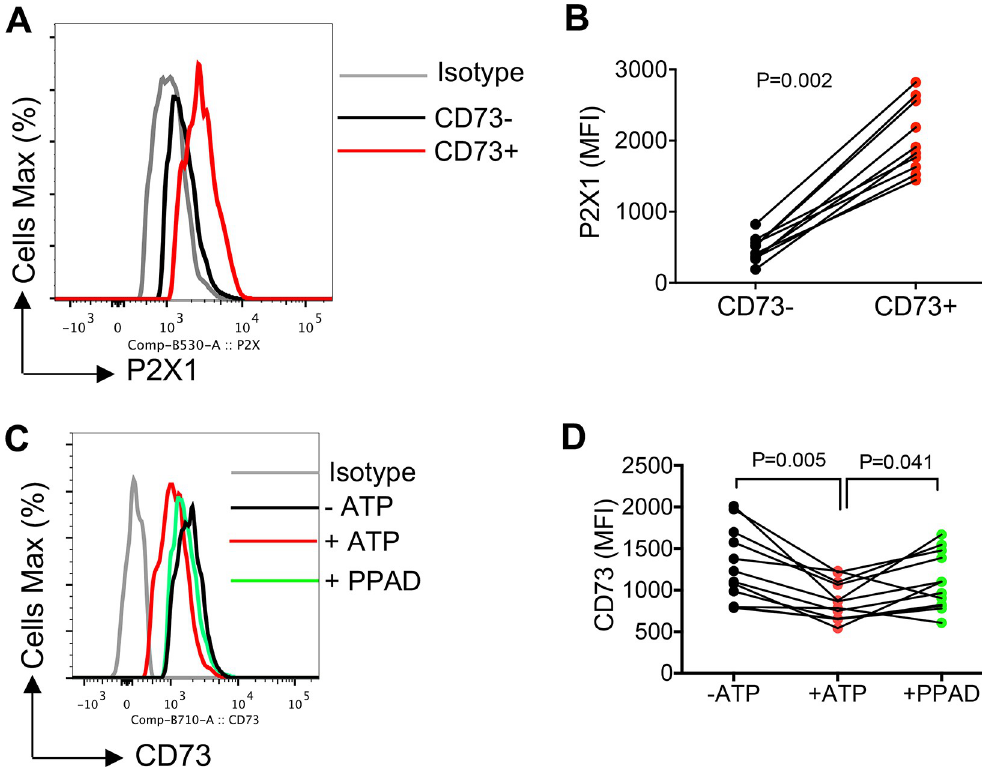
Fig 7. P2X1 is strongly expressed on CD73 + CD8 + T cells and its inhibition partially restores the potential effects of ATP. ( A ) Representative histogram plots, and ( B ) cumulative data showing P2X1 expression in CD73 - /CD73 + CD8 + T cells. ( C ) Representative histogram plots, and ( D ) cumulative data of CD73 expression with/without treatment with ATP (25 μ M) and PPAD (20 μ M) for 48 hr. Statistical analysis determined by the Mann-Whitney U-test (B), Wilcoxon matched-pairs test (D) with significance indicated. Each dot represents results from a study